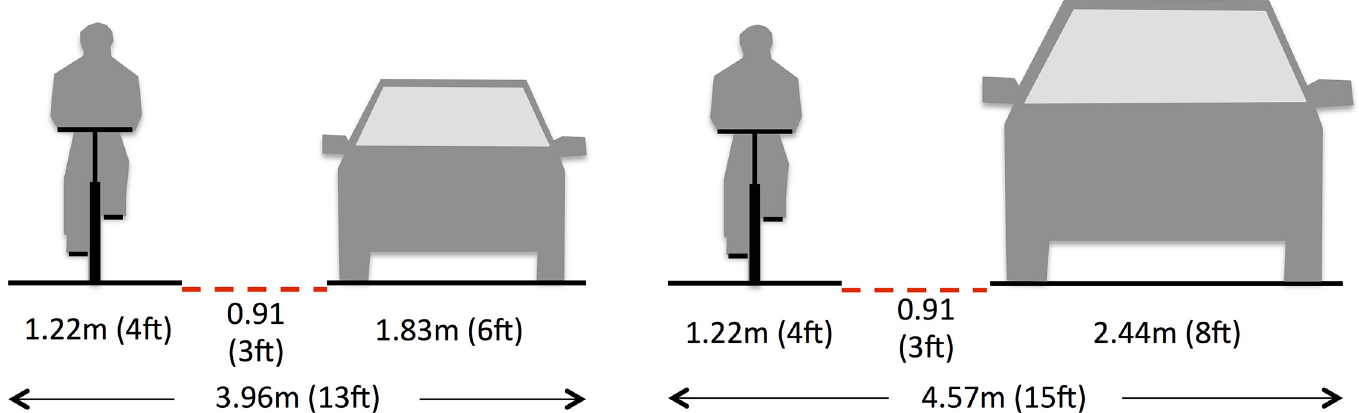
Fig 1. Geometry of lawfully passing a bicyclist. Depiction of two common US motor vehicles (typical sedan on the left, pickup truck/sport utility vehicle on the right), 0.91m (3ft) minimum lateral passing distance required in most states (red dashed line), and typical 1.22m (4ft) operating space for bicyclists. The resultant total width does not include any “ shy distance, ” typically 0.46m (1.5ft) that motorists and bicyclists keep away from hazardous objects, between the motor vehicle and the lane marking to its left, or between the bicyclist and the edge of the